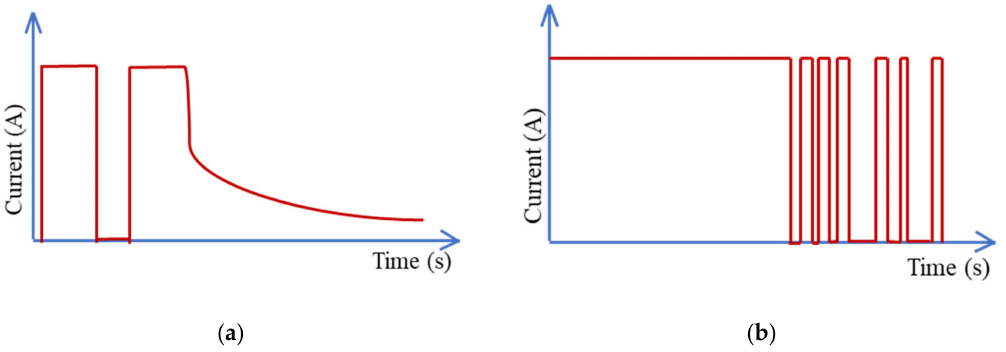
Figure 8. ( a ) Pulse Charging Current-Constant Voltage (PCC-CV) protocol, and ( b ) Constant Current- Pulse Charging Current (CC-PCC) protocol.